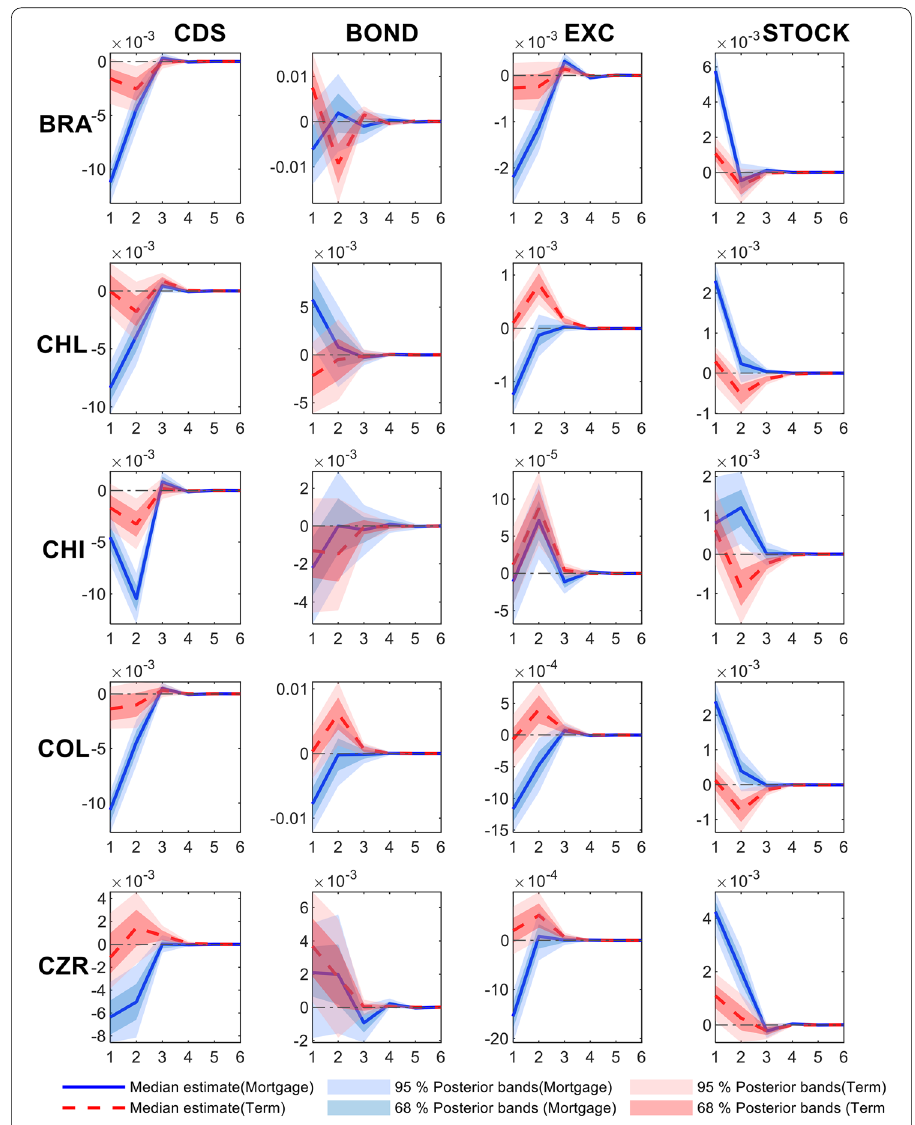
Fig. 13 Responses of individual emerging economies to US UMP shocks. Notes The solid lines indicate the median estimate of the responses to a one standard deviation decline in US mortgage spread while the dashed lines show the median estimate of the responses to a one standard deviation decline in US term spread. Dark (light) shaded areas represent the 68% (95%) posterior probability bands. The posterior bands are based on 10.000 accepted draws, of which we discard the first 2.000 as burn-in